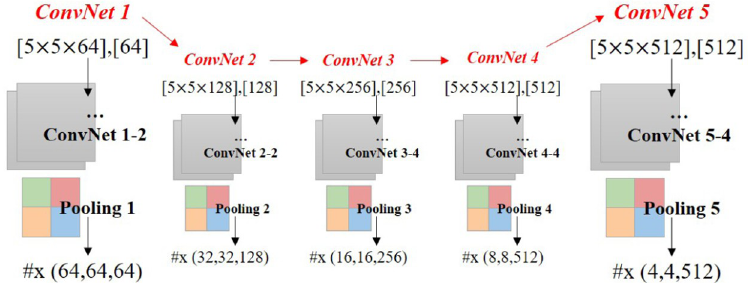
Fig 9. Denoising convolutional neural network architecture (input: x(128, 128, 3), [weight], [bias], #x(width, height, depth), final output: x(4, 4, 512)).